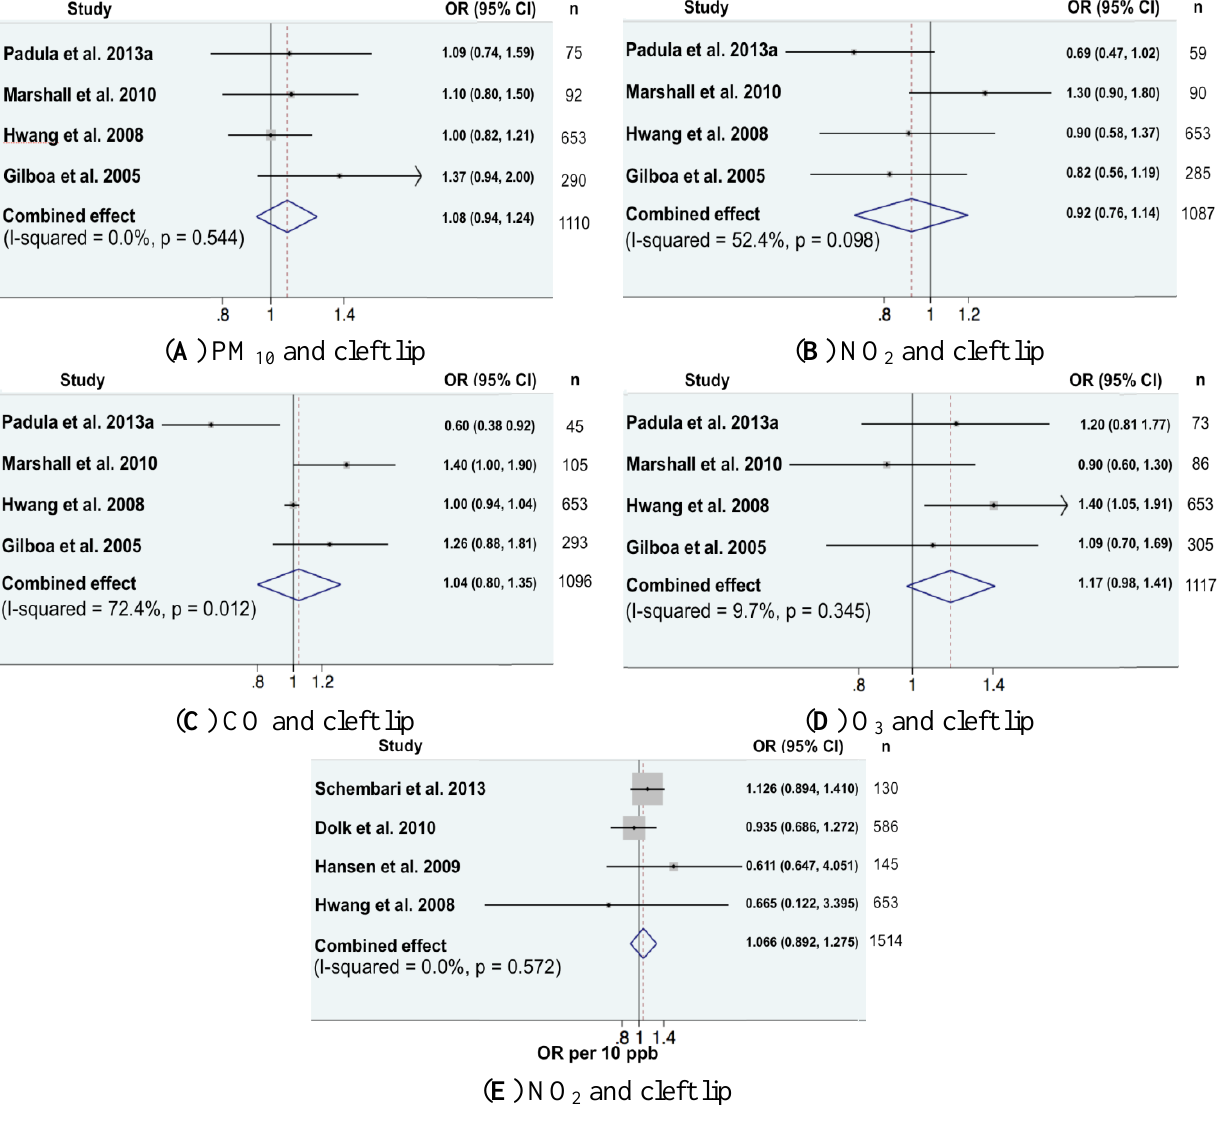
, NO , CO and O ; ( E ) was the combined effect 10 2 3